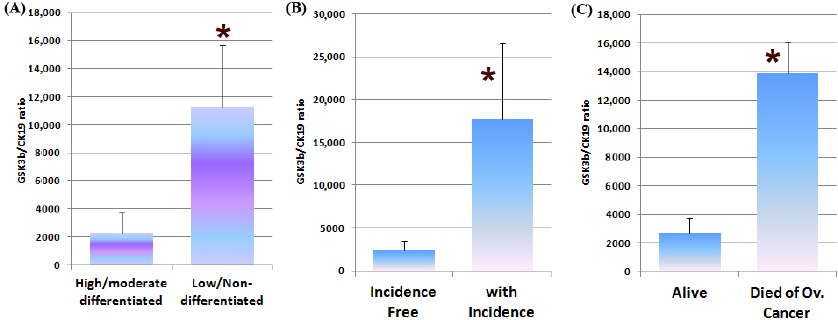
Figure 5. Transcript levels of GSK3 β in clinical cohort. When normalised to CK19, GSK3 β levels were significantly increased in low and non-differentiated tumours ( A ). Significantly elevated transcript levels were also correlated with recurrence ( B ) and with those patients that had died from ovarian cancer ( C ). * p < 0.05.